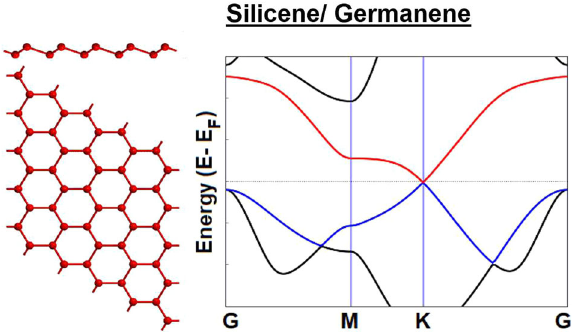
Fig. 8 Structure and Electronic Properties of Silicene/Germanene. The side-view and top view representations (5 × 5 × 1 Supercell) of the monolayer Silicene/Germanene and its energy- crystal wave vector (E-k) dispersion relations where the conduction band and valance band are marked in red and blue,